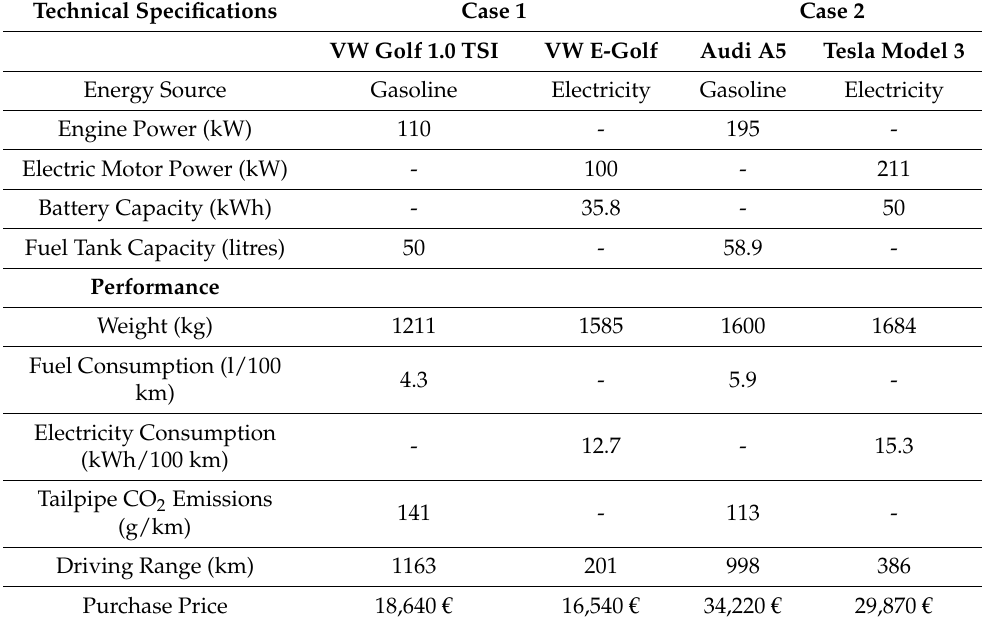
Table 1. Technical specifications for vehicles